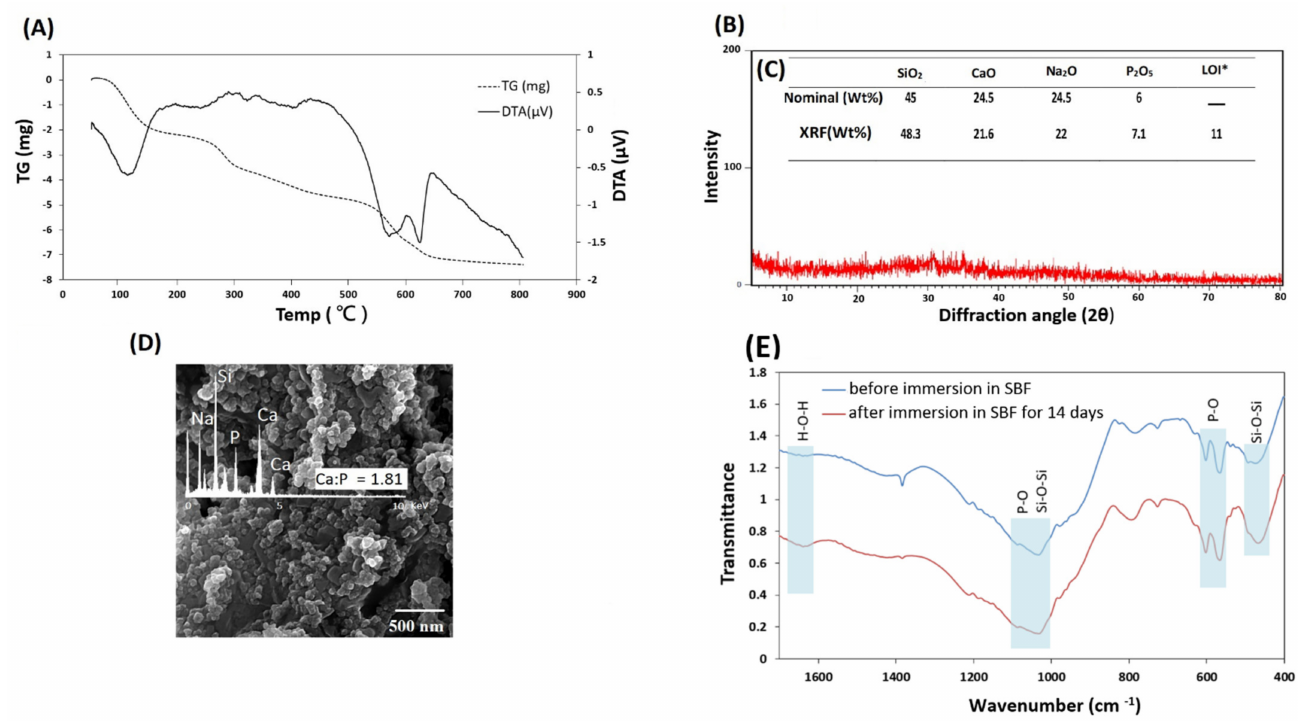
Figure 2. ( A ) DTA-TGA thermogram of 45S5 powder; showing a three-stage mass loss in TG and two exothermic and endothermic peaks in DTA curve. ( B ) XRD pattern of heat-treated BG; demonstrating amorphous structure. ( C ) Elemental analysis of 45S5 powder revealing similarity of the weight percentages to standard weight percentages of 45S5. * LOI: loss on ignition. ( D ) FESEM micrograph and EDS spectrum of synthesized 45S5 Bioglass powder after immersion in SBF for 14 days. ( E ) FTIR spectra of 45S5 Bioglass powder before and after immersion in SBF for 14 days. Abbreviations used in this Figure are as follows: Ca: calcium, P: phosphor, SBF: simulated body